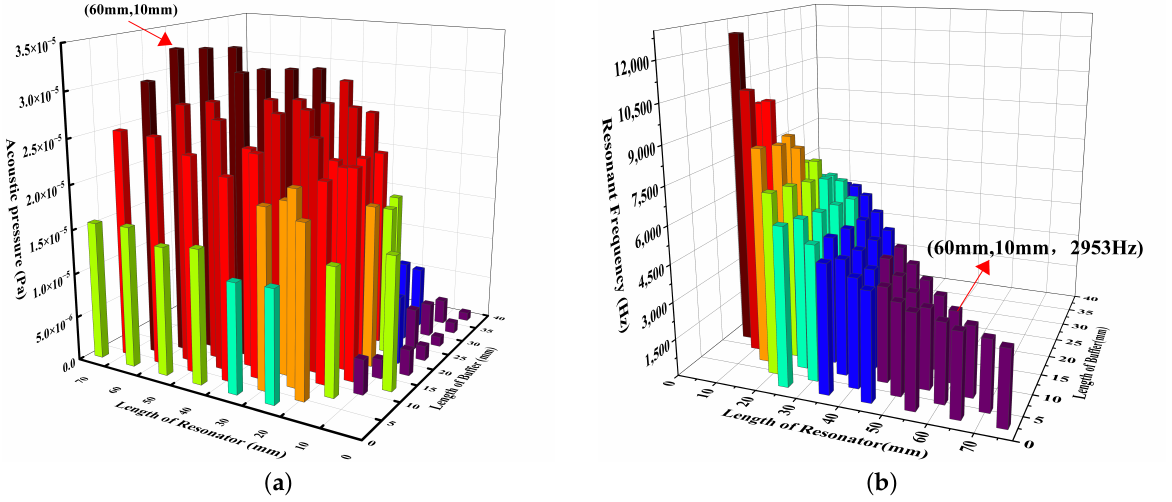
Figure 2. Finite simulation for photoacoustic cell: ( a ) The acoustic pressure of the simulation; ( b ) The frequency of the simulation.